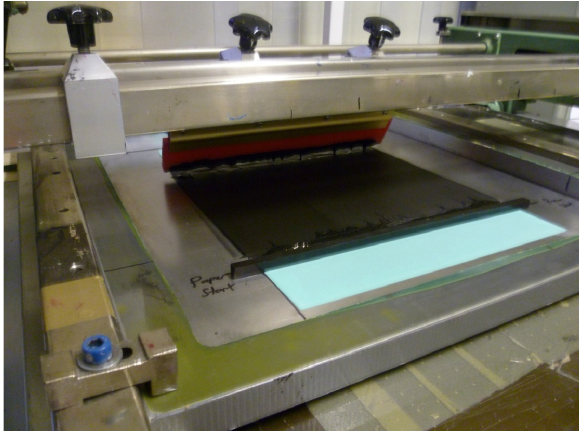
Figure 3. Controlled wearing of a squeegee, using silicon carbide abrasive, on a screen printing press.